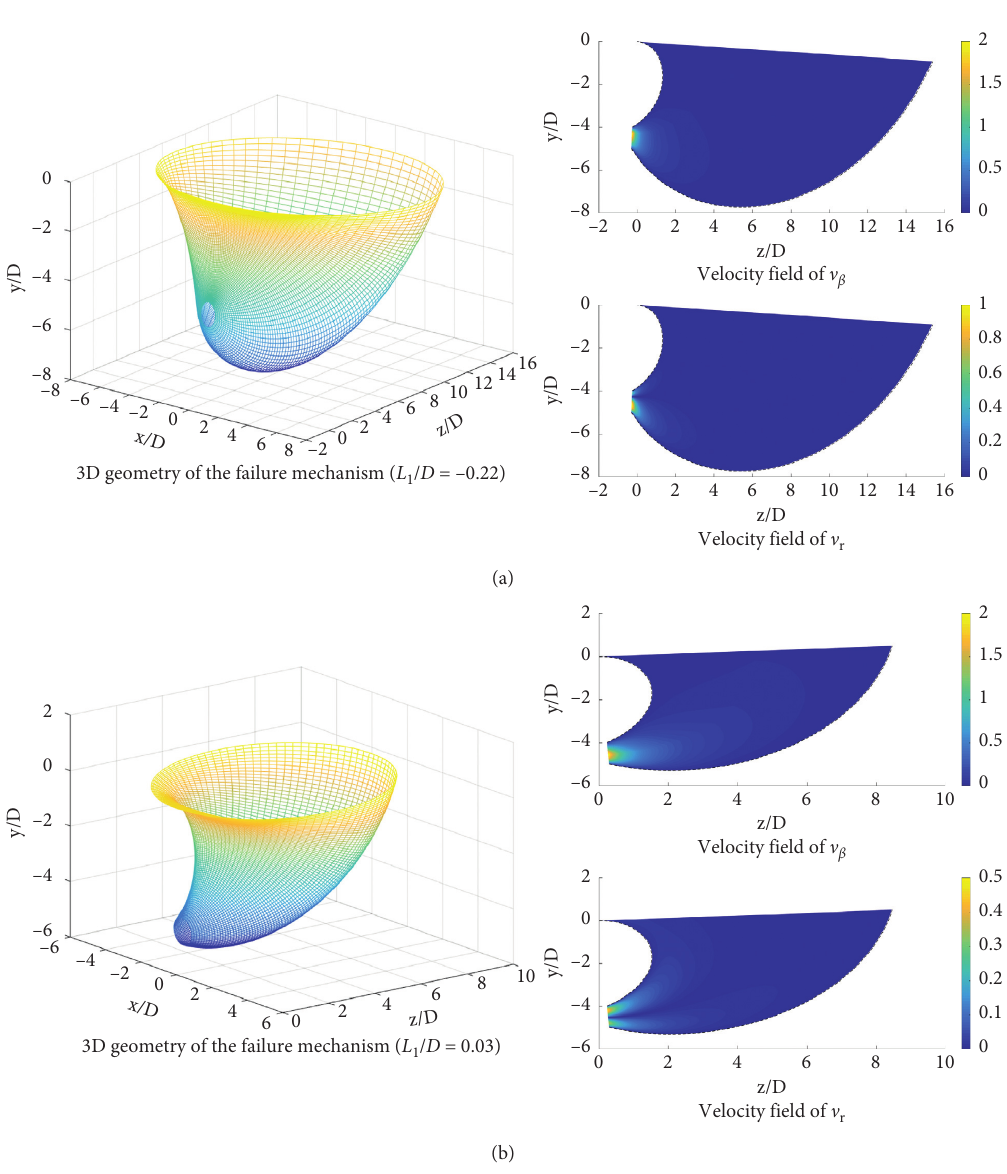
� 10, and η � 6%): (a) tunneling in u